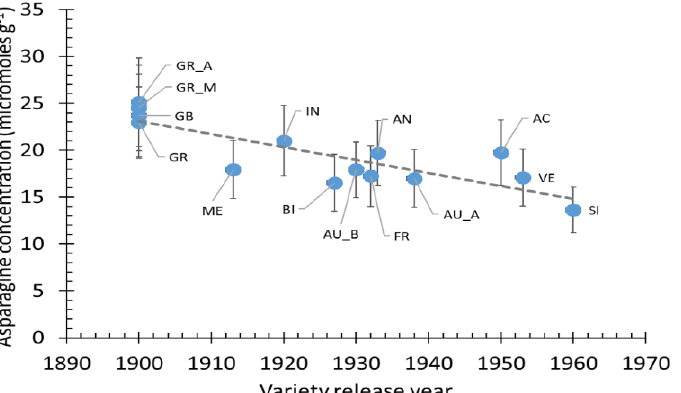
Figure 6. Scatter plots of free asparagine concentration in grain as a function of the variety year of release.